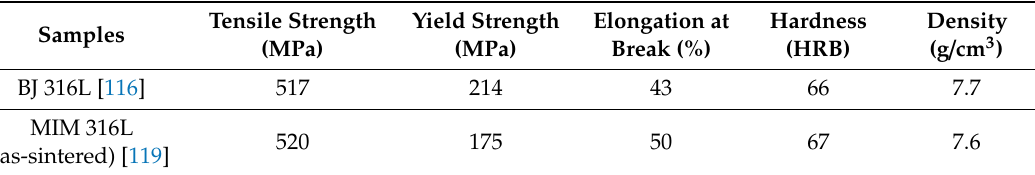
Table 13. Mechanical properties of 316L for manufactured BJ part and MIM materials (American Society for Testing and Materials (ASTM)-B883).